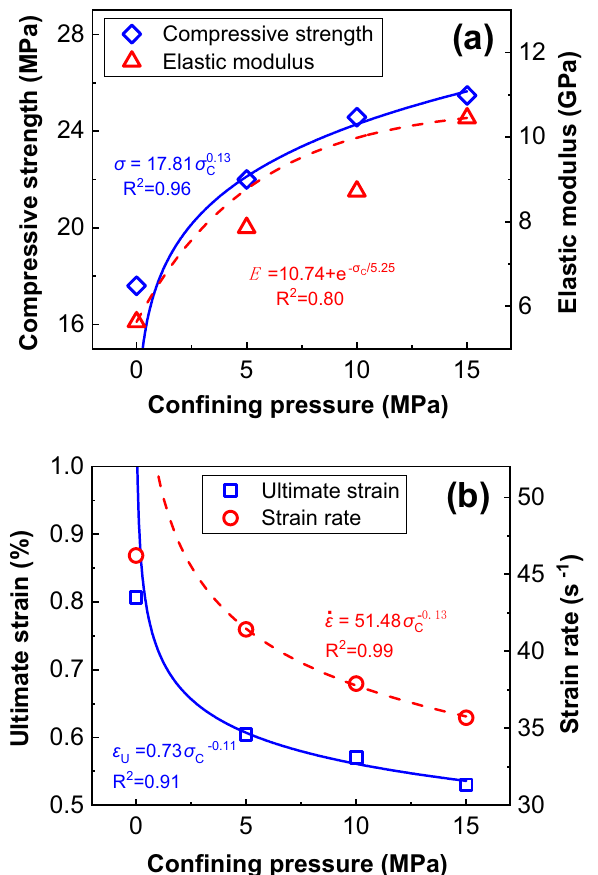
Figure 15. Fitting diagram of mechanical properties of combined bodies under different confining pressures. ( a ) compressive strength and elastic modulus, ( b ) ultimate strain and strain